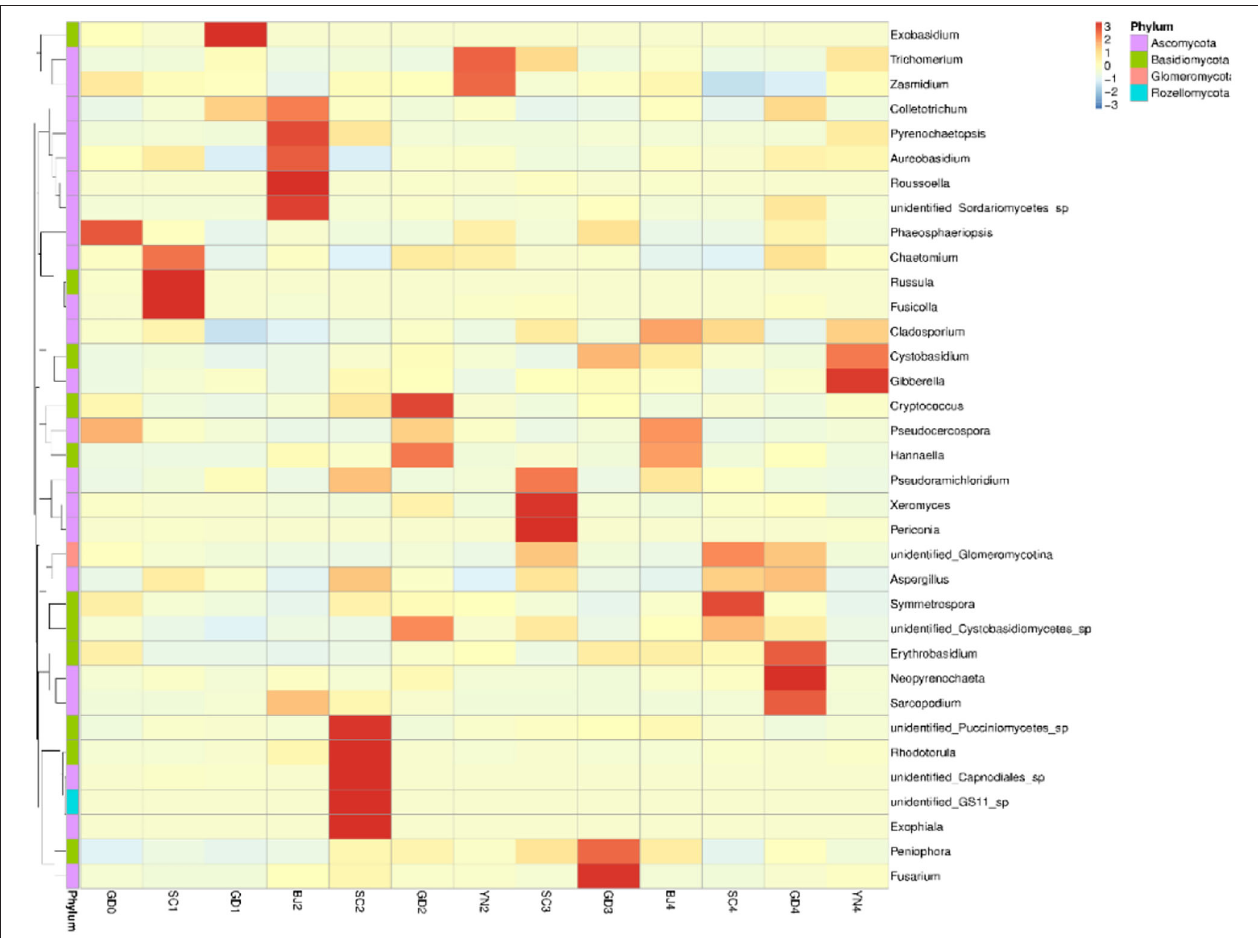
FIGURE 5 | Heatmap depicting relative species abundance. Plotted by sample name on the X-axis and the Y-axis represents the genus. The cluster tree on the left side of the graph is a species cluster tree.